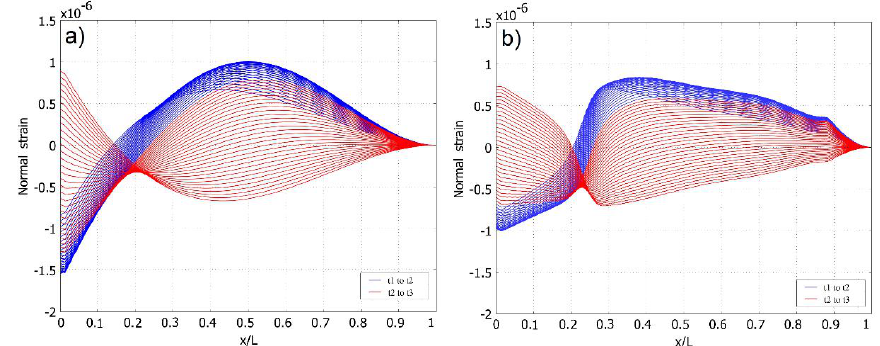
Figure 6. Normal strain distribution versus the length of the cantilever per ½ T obtained from transient analysis: ( a ) cantilever of a constant cross-section; ( b ) optimally-shaped cantilever. Sensors 2015 , 15 , page–page